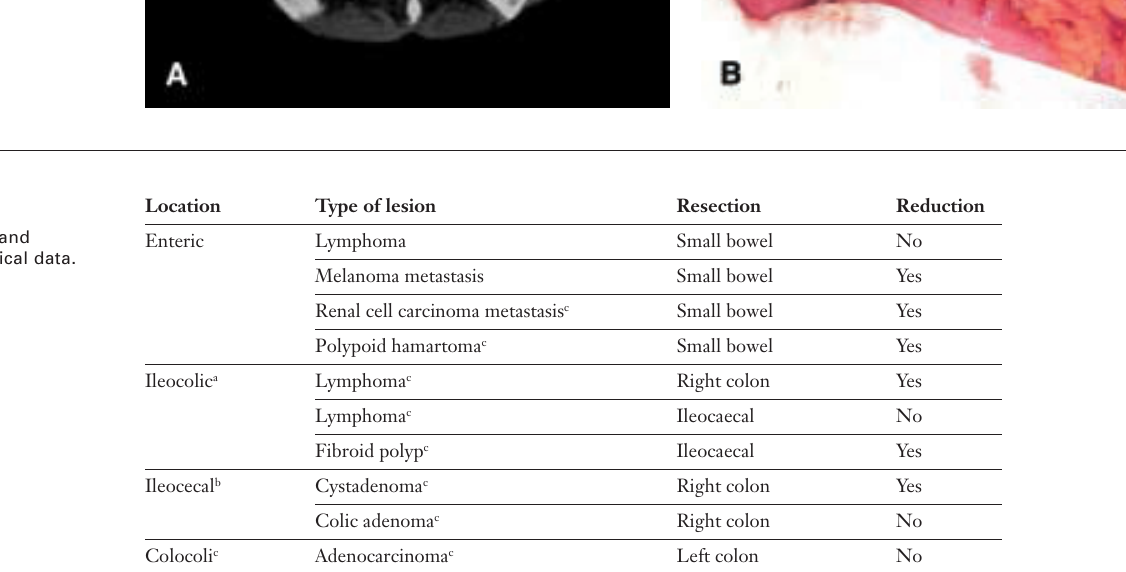
Ileocecal intus- susception. A: CT presentation with classical image of traget (*); B: intraoperative presentation.